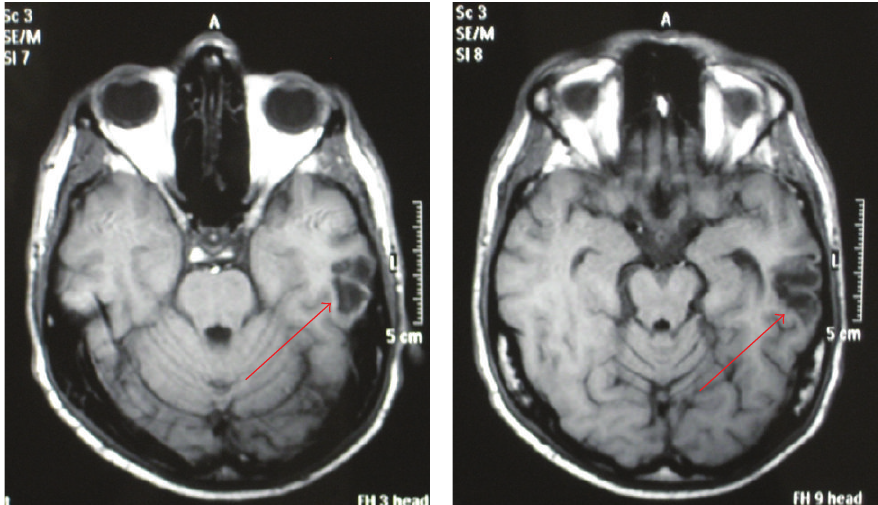
Figure 2: Brain MRI examination (axial T1-weighted sequence). The arrows point to an hypointensity area mainly involving left temporal subcortical white substance. It is likely to be an ischemic lesion with partial hemorrhage. Day 1 after diving